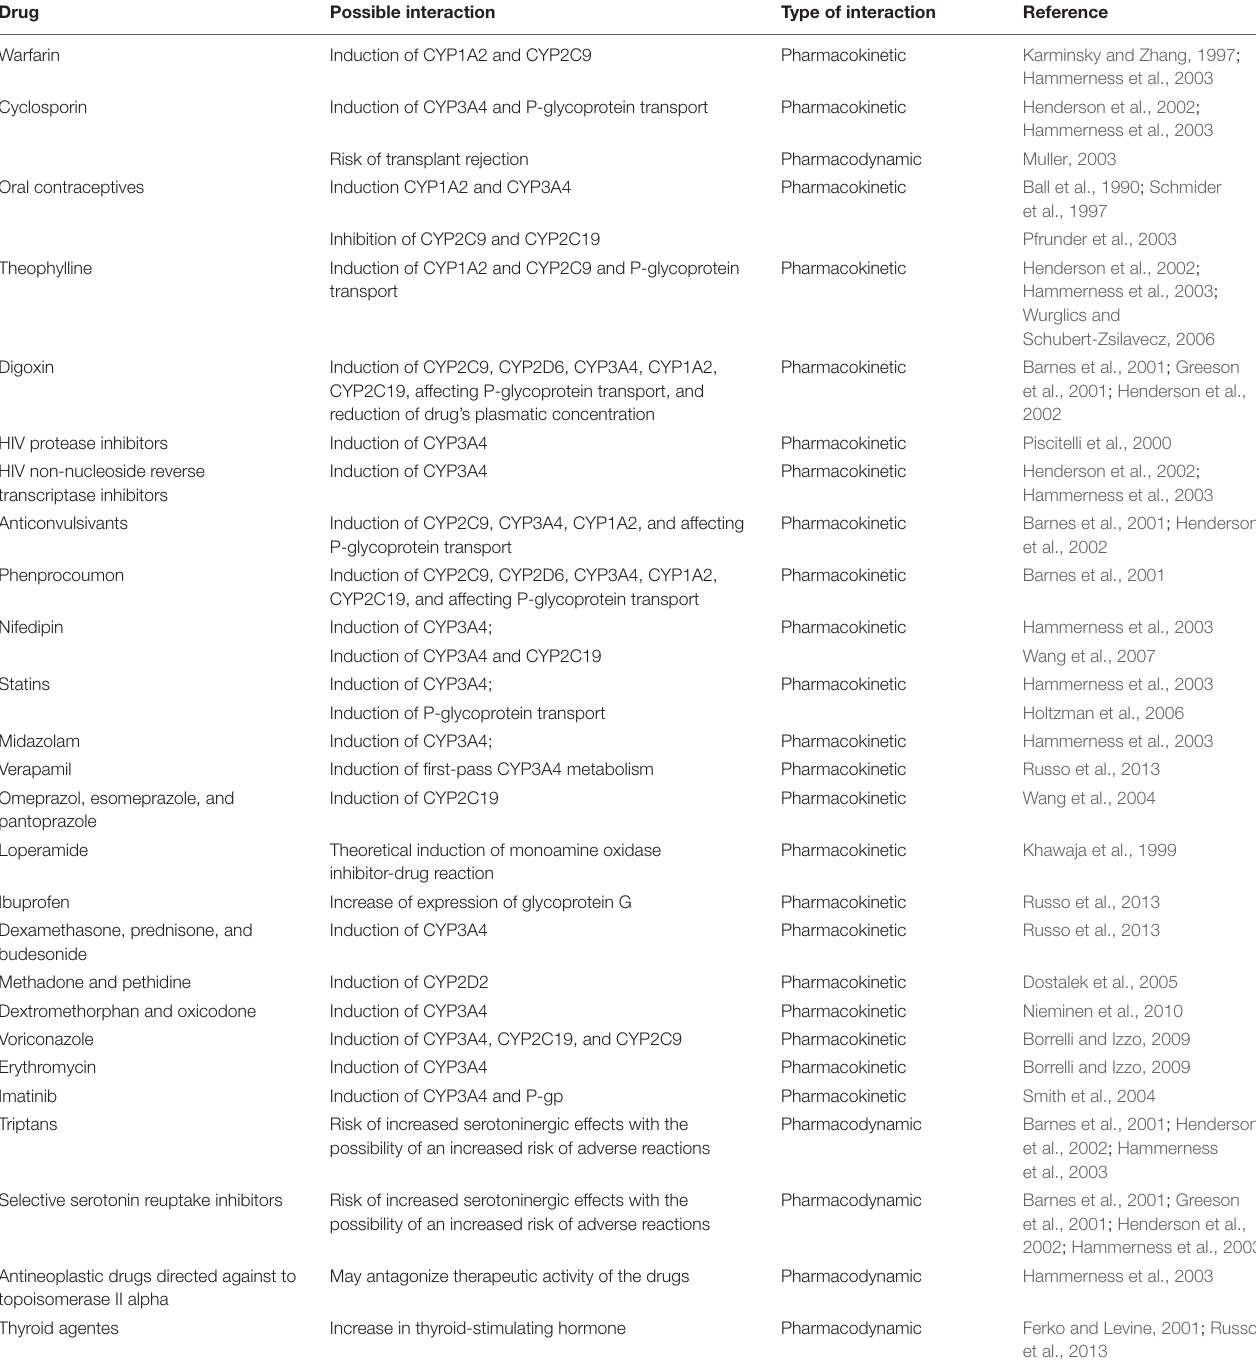
TABLE 1 | Hypericum perforatum– drug